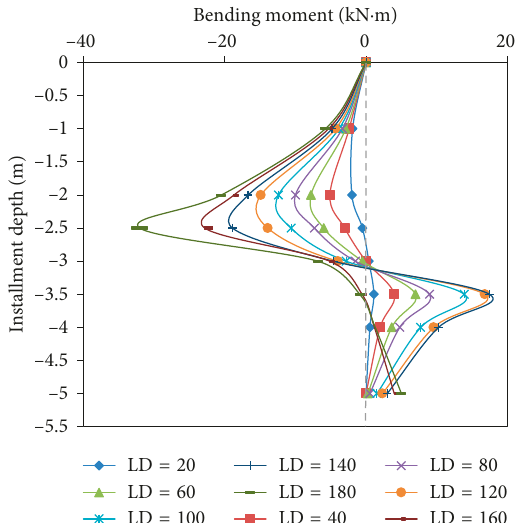
Figure 15: Variation of bending moment with installment depth for Test D No. 1 (loading displacement short for LD).